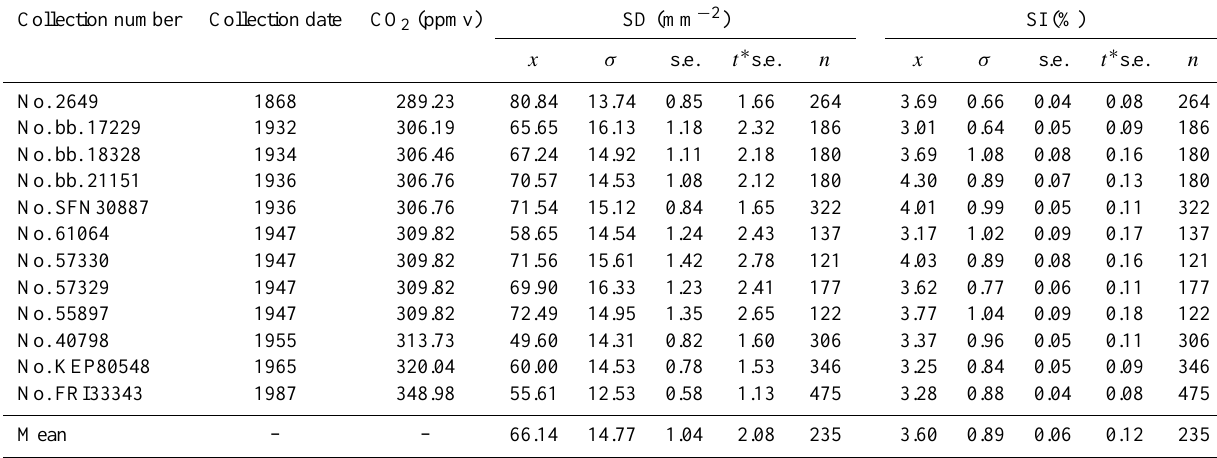
Table 4. Summary of stomatal parameters of the combined data of the adaxial and abaxial surfaces from modern Nageia motleyi (Parl.) De Laub.